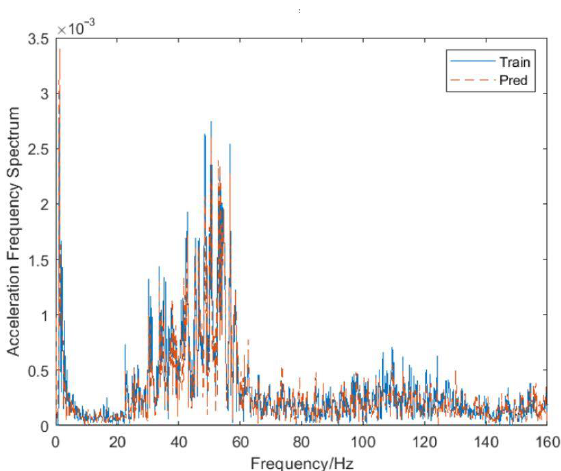
Figure 20. Comparison of acceleration frequency spectrum from Channel 7 using processed data.